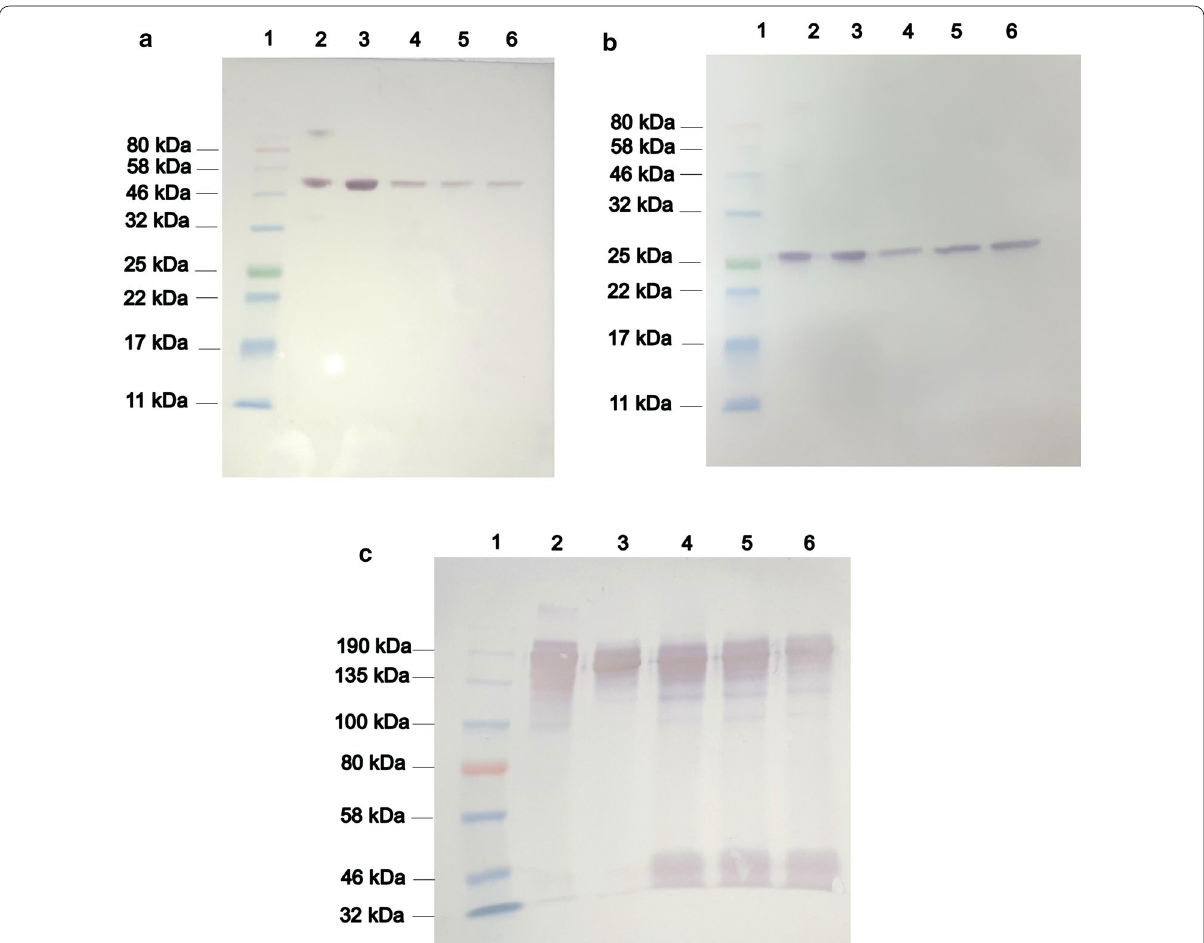
Fig. 9 Analysis of biosimilar candidate to trastuzumab in cell culture supernatant by Western blotting. Cell culture supernatants of cells growing in chemically defined, protein‑free medium and shaking culture were loaded in 12% SDS‑PAGE/reducing conditions ( a and b ) and 7.5% SDS‑PAGE/ non‑reducing conditions ( c ). Immunodetection of heavy chain ( a ) was performed using an AP‑conjugated goat anti‑human IgG (γ chain specific) antibody. Immunodetection of light chain ( b ) and antibody whole molecule ( c ) was performed using a HRP‑conjugated goat anti‑human kappa light chain antibody. 1: Pre‑stained molecular weight marker (NEB, UK). 2: biosimilar to trastuzumab obtained from NS0 cells (2.5 μg) (named 5G4). 3: Commercial trastuzumab (2.5 μg). 4: Cell culture supernatant of 5B12 clone. 5: Cell culture supernatant of 1B6 clone. 6: Cell culture supernatant